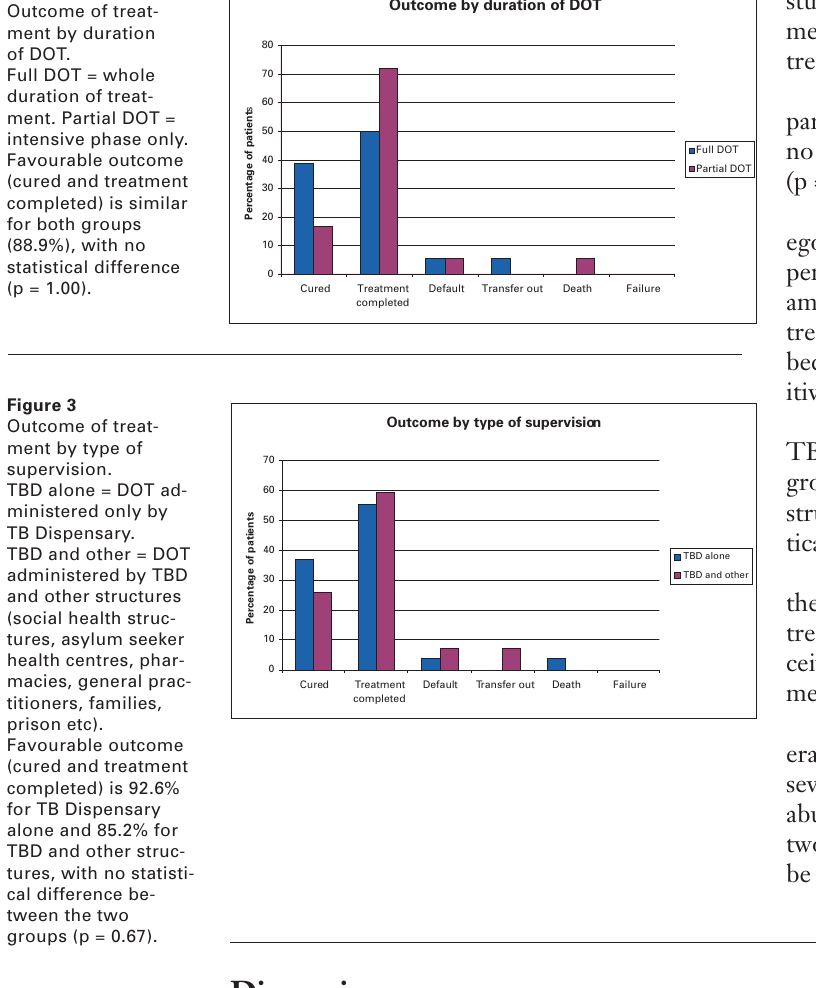
Figure 2 Outcome of treat- ment by duration of DOT.